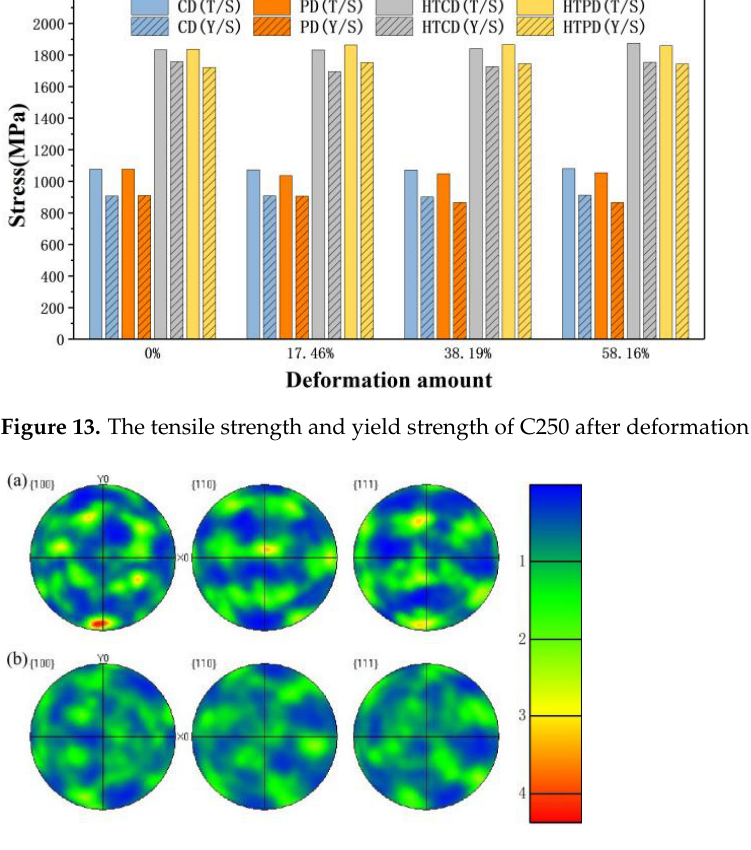
Figure 14. EBSD pole figures of C250: ( a ) After deformation; ( b ) After heat treatment.